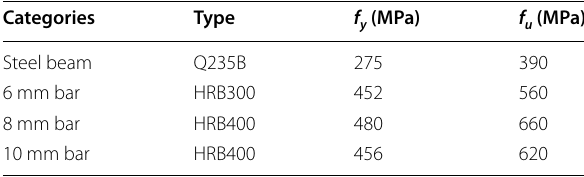
Table 2 Steel material performance test